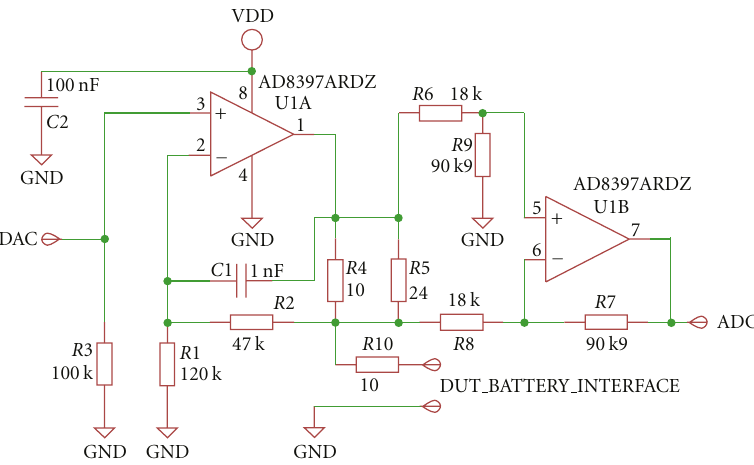
Figure 7: Electronic circuit schematic of the energy-harvesting